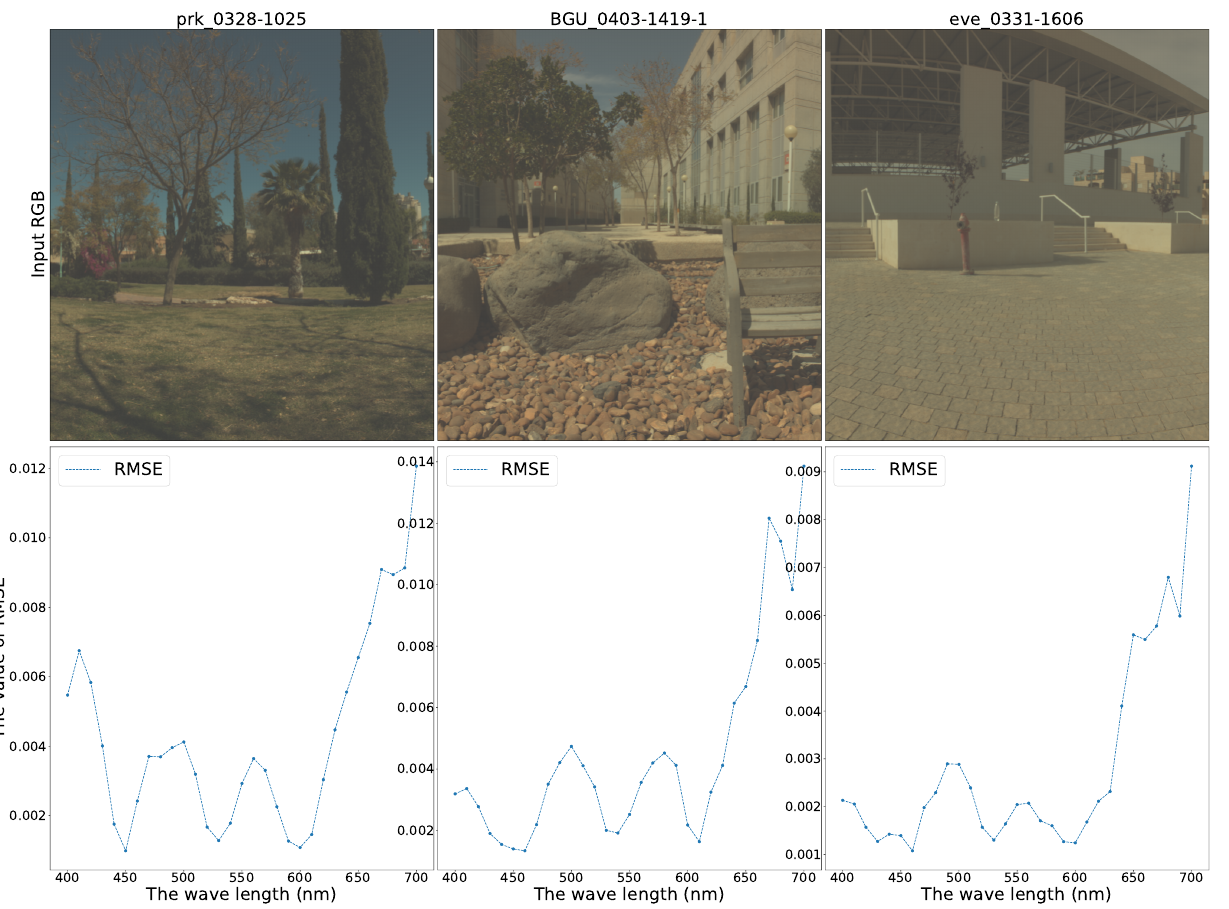
Figure 13. The RMSE waveline of multispectral image restoration on the ICVL